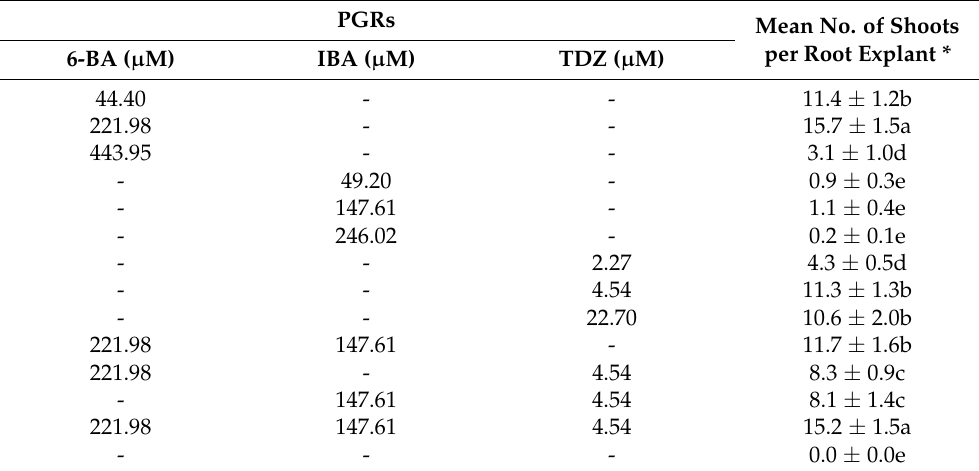
Table 1. Effects of different PGRs on shoot induction.